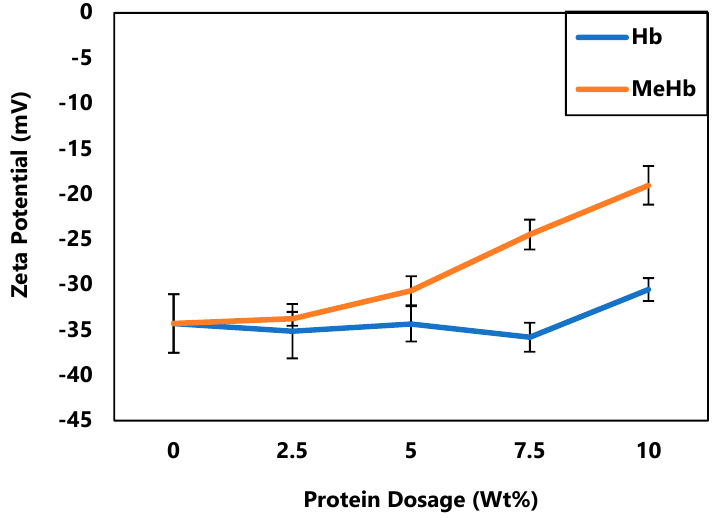
Figure 5. Zeta potential measurement of conditioned sludge with hemoglobin and methylated hemoglobin.